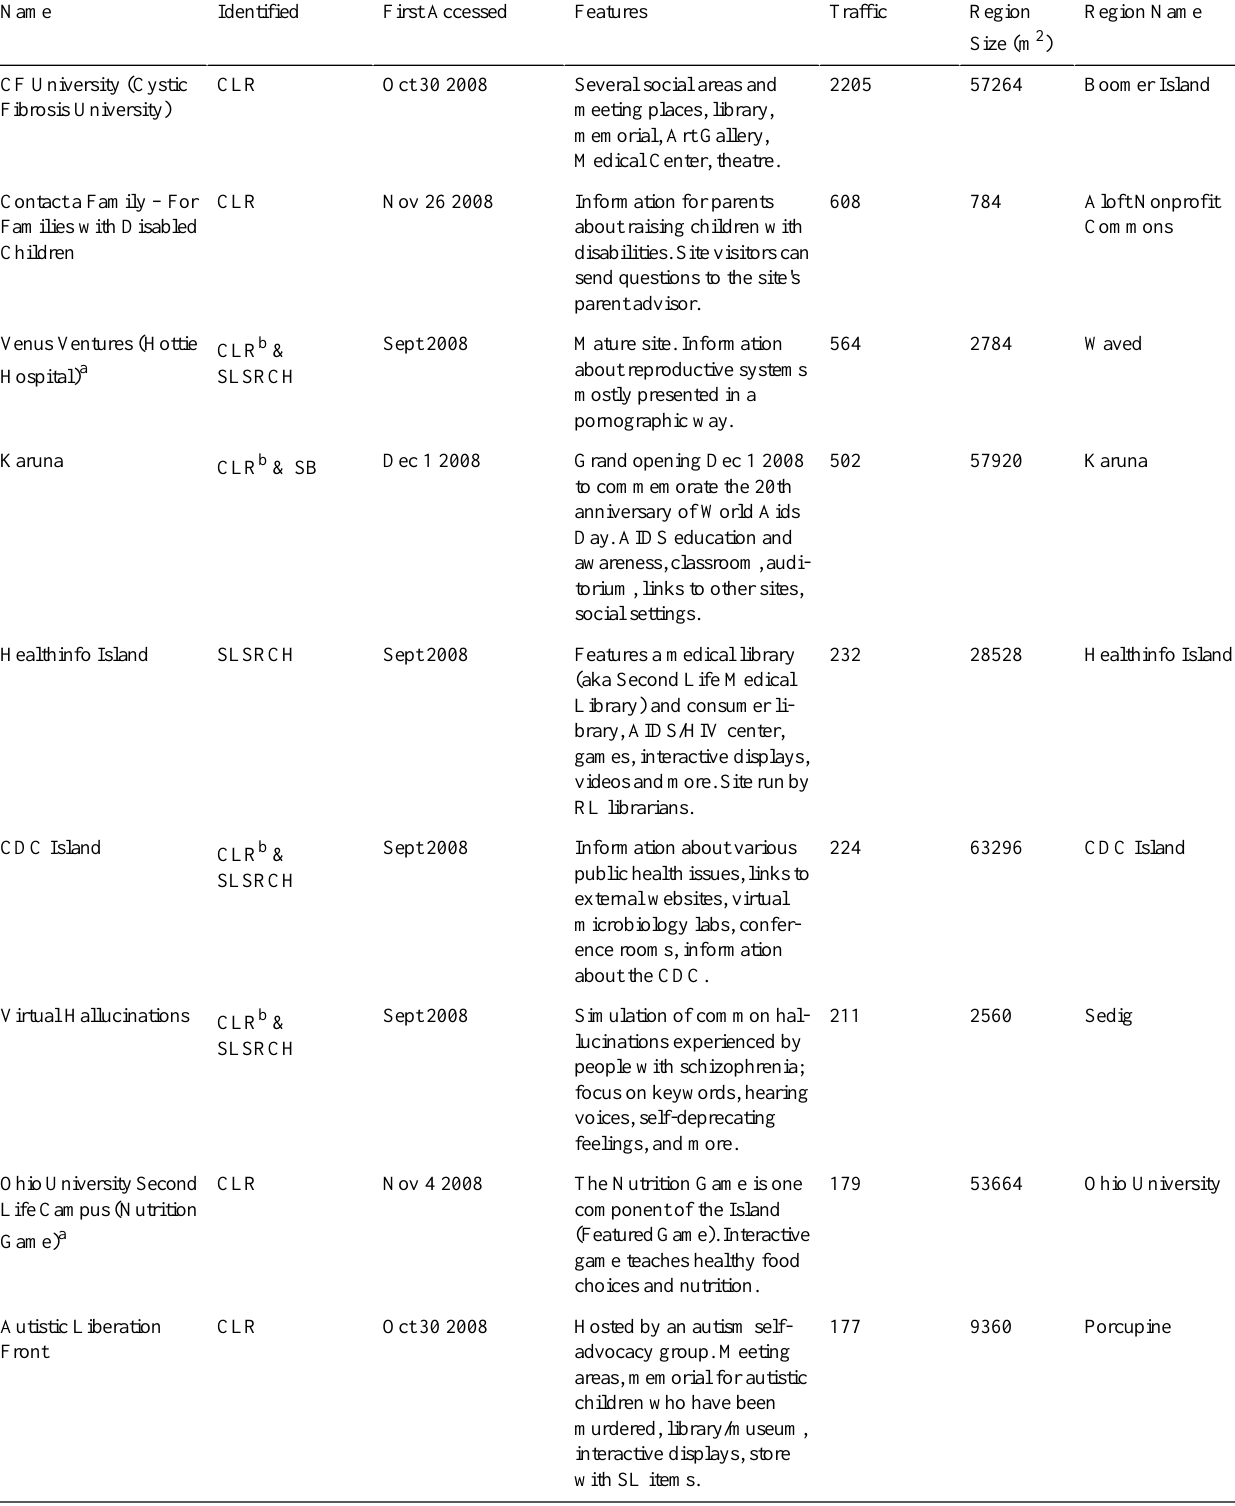
Table 2. Selection of health education and awareness sites (top 15 sites — ranked by traffic and, in addition, the University of Plymouth (Sexual Health Sim) which is discussed in article). See Appendix 1 for the complete results for this